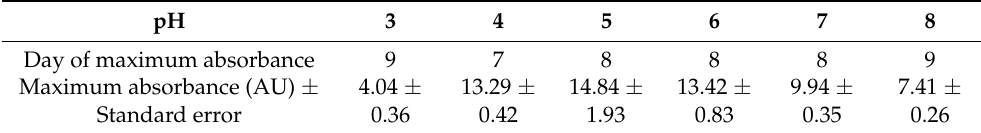
Table 1. Maximum absorbance at 470 nm in shake flasks representing the region for orange pigments. pH 3 Maximum absorbance (AU) ± Standard error